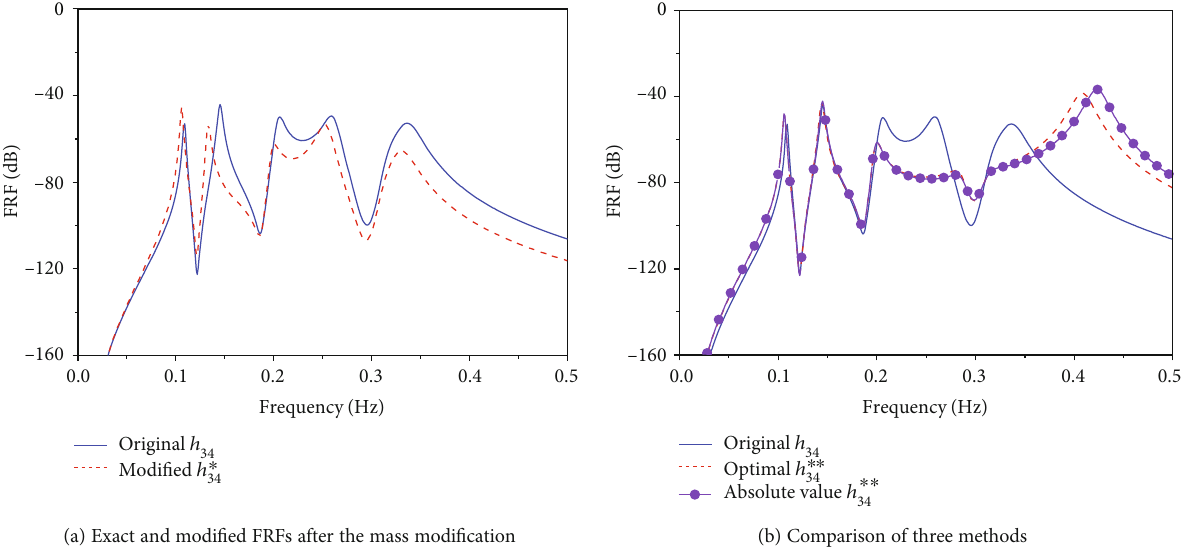
Figure 9: Comparison of FRFs between original and modi fi ed systems with modal damping ratio